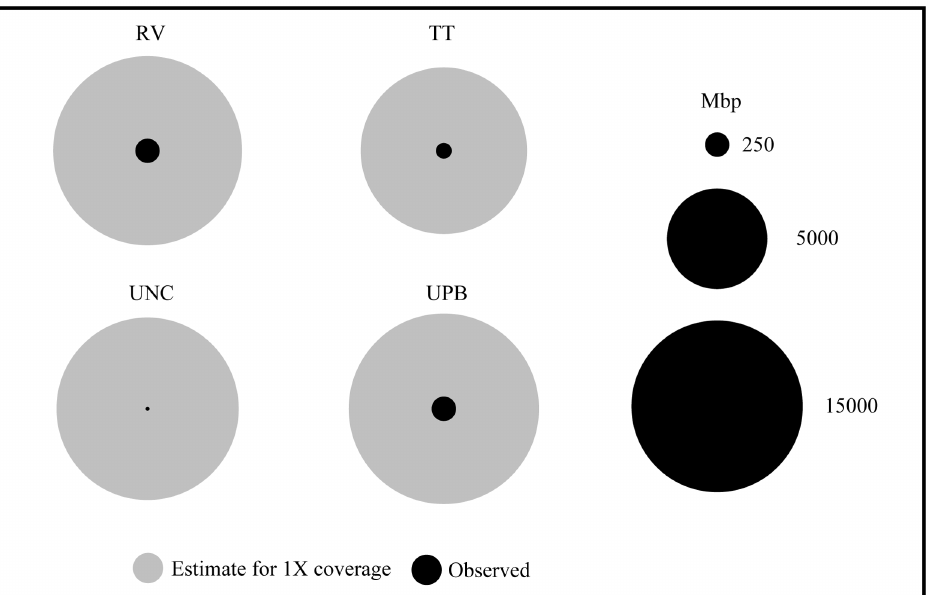
Figure 8. Plots of the average number of base-pairs (in millions) observed and estimates of quantity necessary to achieve approximately 1X coverage across all genomes present in cultured and uncultured samples. treatment along Axis 2 of the PCoA plot. Axis 1 predominantly differentiates uncultured samples from the enrichment samples.